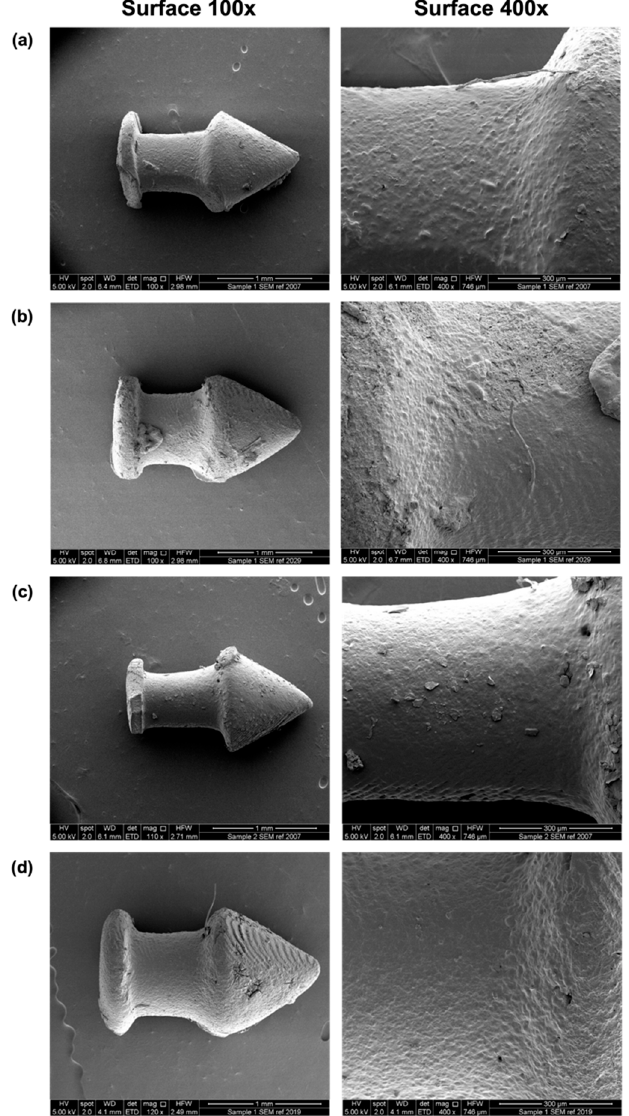
Figure 4. SEM images of the DLP 3D printed ( a ) D10, ( b ) D20, ( c ) D10PEG and ( d ) D20PEG punctal plugs. The scale bar is equivalent to 1 mm (surface 100×) and 300 μ m (surface 400×).